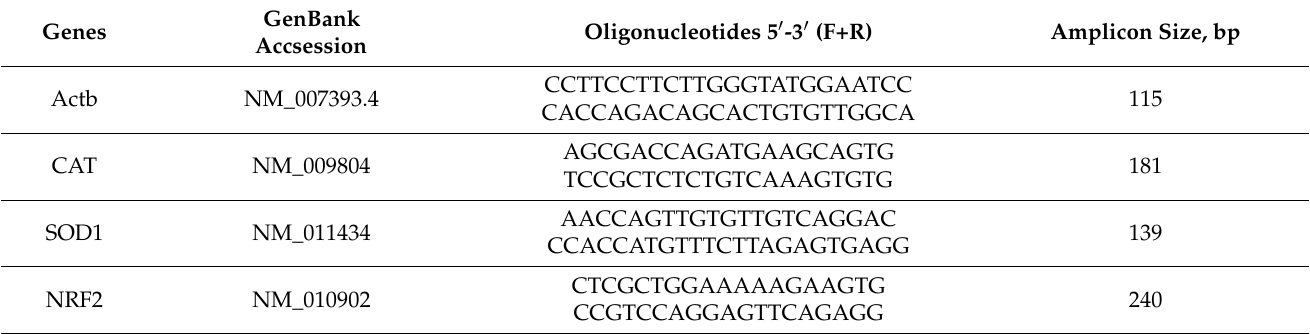
Table 4. Oligonucleotides used for qRT-PCR. The design of oligonucleotides was carried out with the use of Primer-BLAST (www.ncbi.nlm.nih.gov) (10 August 2021). The calculated Tm for all primers is 61–63 ◦ C. Real-time PCR was performed at Tm = 60 ◦ C. PCR products were melted from 60 ◦ C to 90 ◦ C to assess the specificity of the